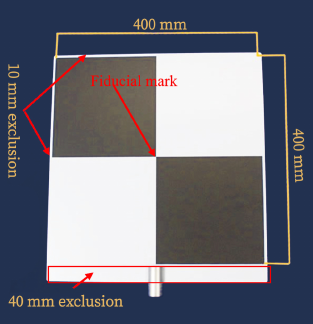
Figure 6. The rectangular laser scanner checkerboard has an area of 450mm × 420mm with a 1/4 inch adapter. As required in the standard, the LiDAR points from the edges of the plate target should not be considered for the point-to-point distance measurement. That is why the exclusion region is defined for the plate target. As a result, the active area of the plate target becomes 400mm × 400mm. In addition, the fiducial mark is defined at the center of the plate target so the RI can aim directly at it for the reference distance